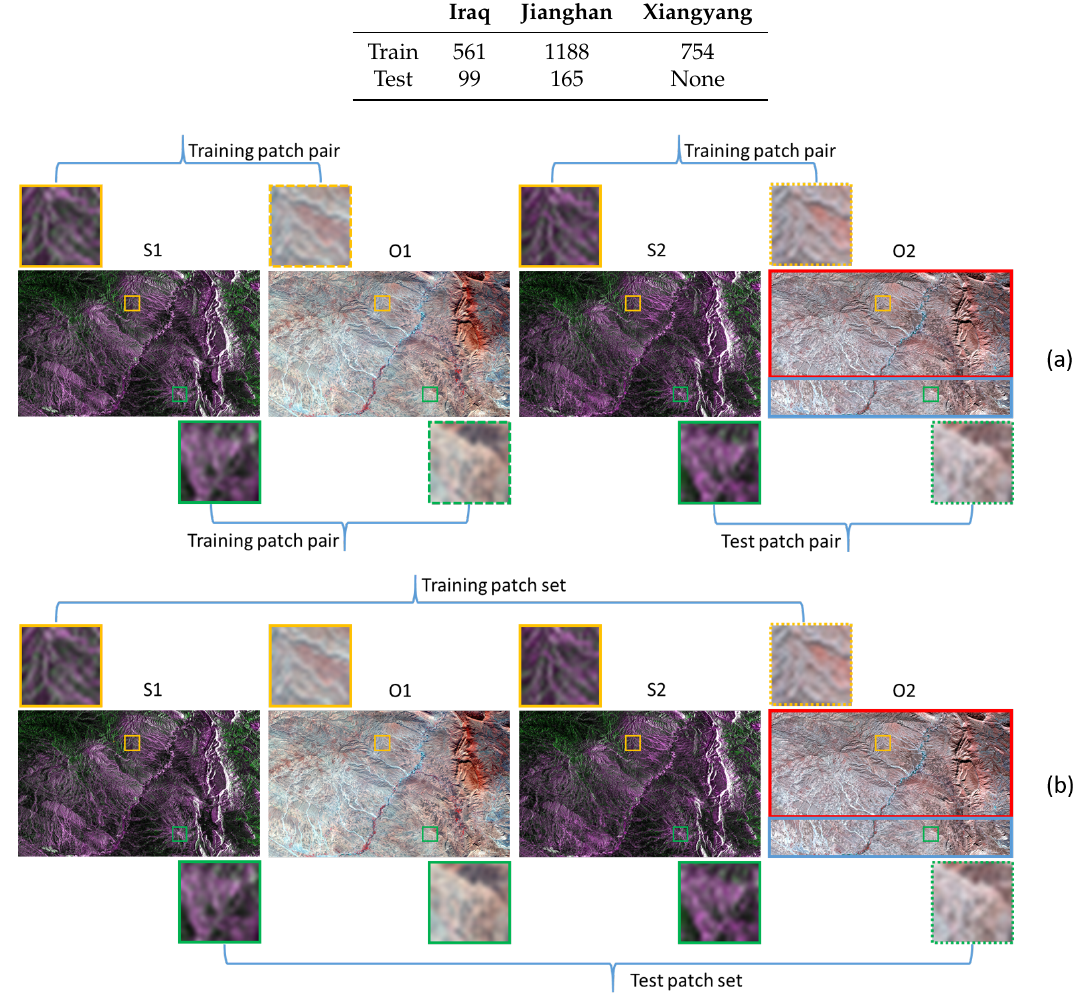
Figure 6. Illustration of training and test patch pairs with Iraq dataset for ( a ) Task A, and ( b ) Task